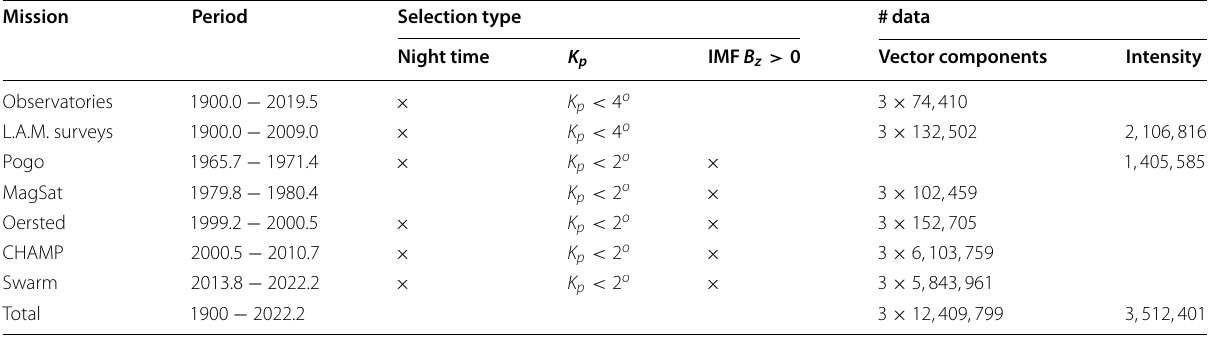
Selection criteria applied the data: night-time (third column), K p threshold (fourth column) and positiveness of the z-component of the IMF (fifth column). Number of vector field components (sixth column) and intensity measurements (seventh column) Percentage of rejected data through the (eighth column)